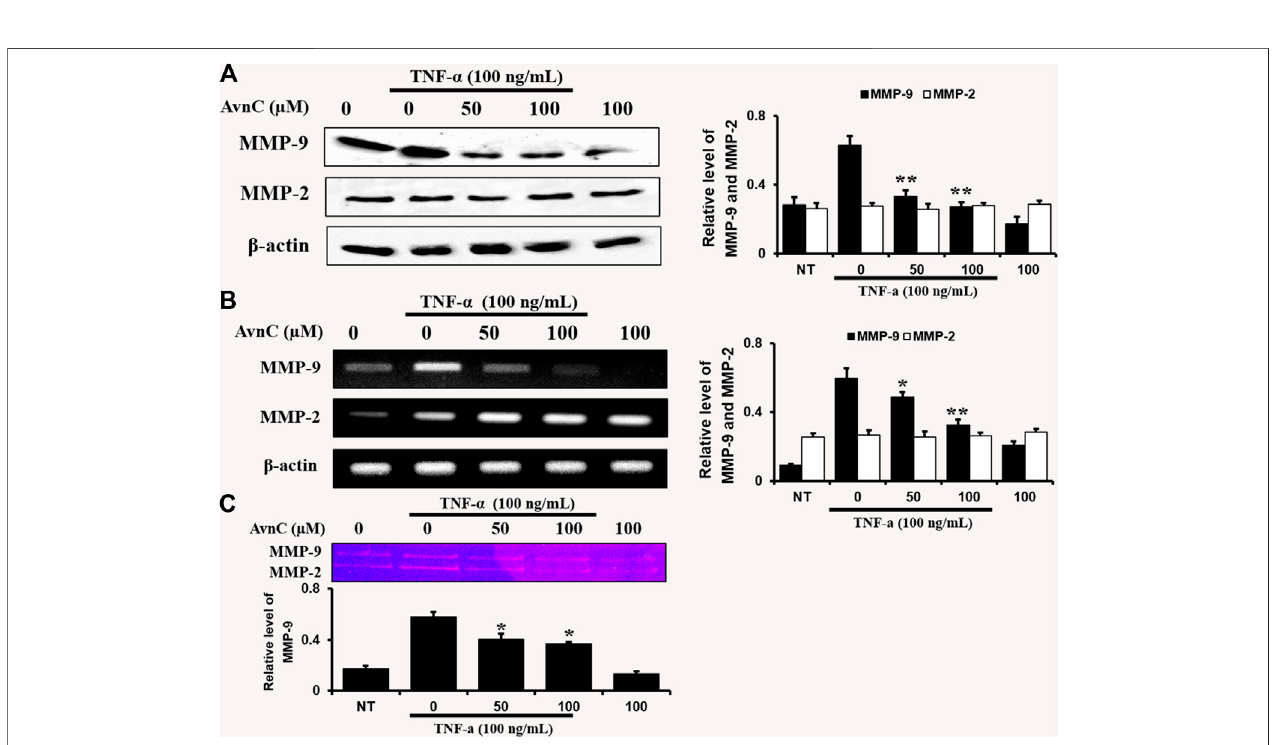
FIGURE 3 | Effects of Avn C on TNF- α -induced MMP-9 and MMP-2 expression levels in HASMC cells.HASMC cells were co-treated with 0 – 100 μ M Avn C and 100 ng/ml TNF- α for 24 h. Protein (A) and mRNA (B) levels respectively were examined by Western blotting and RT-PCR (C) Gelatin zymography results of MMP-9 enzyme activity levels. Results shown are representative of three independent experiments. They are presented as mean ± SEM. * p < 0.05 and ** p < 0.01, signi fi cant differences from the TNF- α treated cells. NT, no treatment.